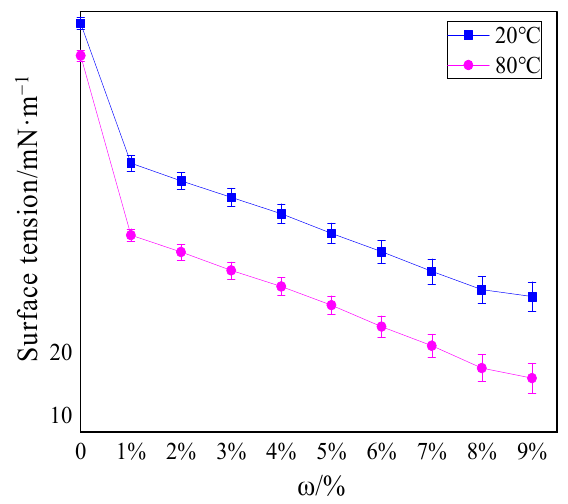
Figure 4. Surface tension of hydrogels with different concentrations at 20 and 80 °C. The surface tension of water at 20 and 80 °C was 72.1 and 67 mN/m, respectively, while the surface tension of 1% hydrogel solution was 50 and 38.61 mN/m, respectively. As the concentrations of hydrogel increased, the surface tension decreased gradually. Significantly, the surface tension decreased to a greater extent after the temperature augmented. The surface tension of the 9% hydrogel solution at 80 °C even dropped to 16 mN/m, exhibiting temperature sensitivity. This similar phenomenon of surface tension varying with temperature was also found in Deng [22] and Jia’s [32] previous research, and the surface tension of the hydrogel prepared by them was at least 32 mN/m at 90 °C. It can be seen from Figure 4 that the decrease in surface tension of the hydrogel solution at 80 and 20 °C fluctuated between 0.55–0.83 times (all less than 0.95 times), and GB 15308- 2006 can confirm that the fire extinguishing fluid was thermosensitive extinguishing fluid. The lower surface tension of thermosensitive hydrogels than water was the result of the interaction between hydrophilic groups and hydrophobic groups in solution, which was also the foremost reason for the thermo-sensitive characteristics of hydrogels. These results had also been explained in Deng and Jia’s research [22,32]. At 20 °C, the hydrophilic groups played a major role, and the hydrogel was fully swollen when it absorbed water. At this point, the hydrogel solution had superior surface activity; consequently, the surface tension was larger. When the temperature rose above 80 °C, the hydrophobic groups attracted each other and clung to each other, and the hydrophilic groups formed micelles outwards. Accordingly, the volume phase transition occurred in hydrogel solution, leading to weakened surface activity; consequently, the surface tension at this time was lower than that at a normal temperature. It can be inferred that when this type of thermosensitive hydrogel was employed to extinguish fires, it was easier to spread on the surface of the burning material than water, thus accelerating the absorption of hydrogel to the heat of the fire site and enhancing the extinguishing effect. 3.3. Viscosity Analysis The thermosensitive hydrogel undergoes significant phase changes under various temperature conditions, the typical process is shown in Figure 5.